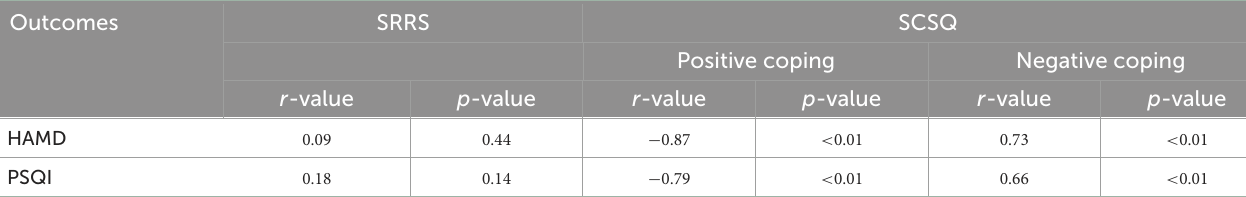
TABLE 7 Correlational analyses between HAM-D 17 /PSQI and SRRS/SCSQ (ITT dataset, participants = 70). Outcomes SRRS SCSQ Positive coping Negative coping